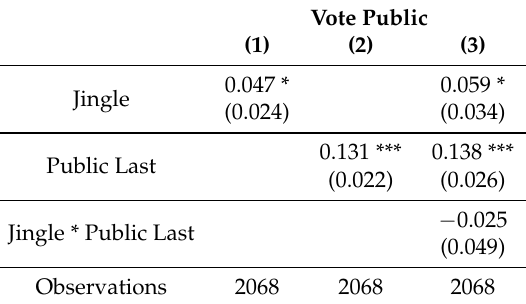
Table 3. OLS regression. The dependent variable is a dummy variable equal to 1 when public and private signals differ, and the subject votes according to the public signal, 0 otherwise. The variable Jingle is a dummy variable equal to 1 when the public information is displayed with a salient video, and the variable Public last is a dummy variable equal to 1 when the public signal is displayed after the private signal. Column (3) shows that, when controlling for order effects, the effect of the jingle remains significant, but the magnitude of recency is higher. Standard errors are clustered at the individual level in parenthesis. * corresponds to p < 0.1 and *** to p < 0.01.